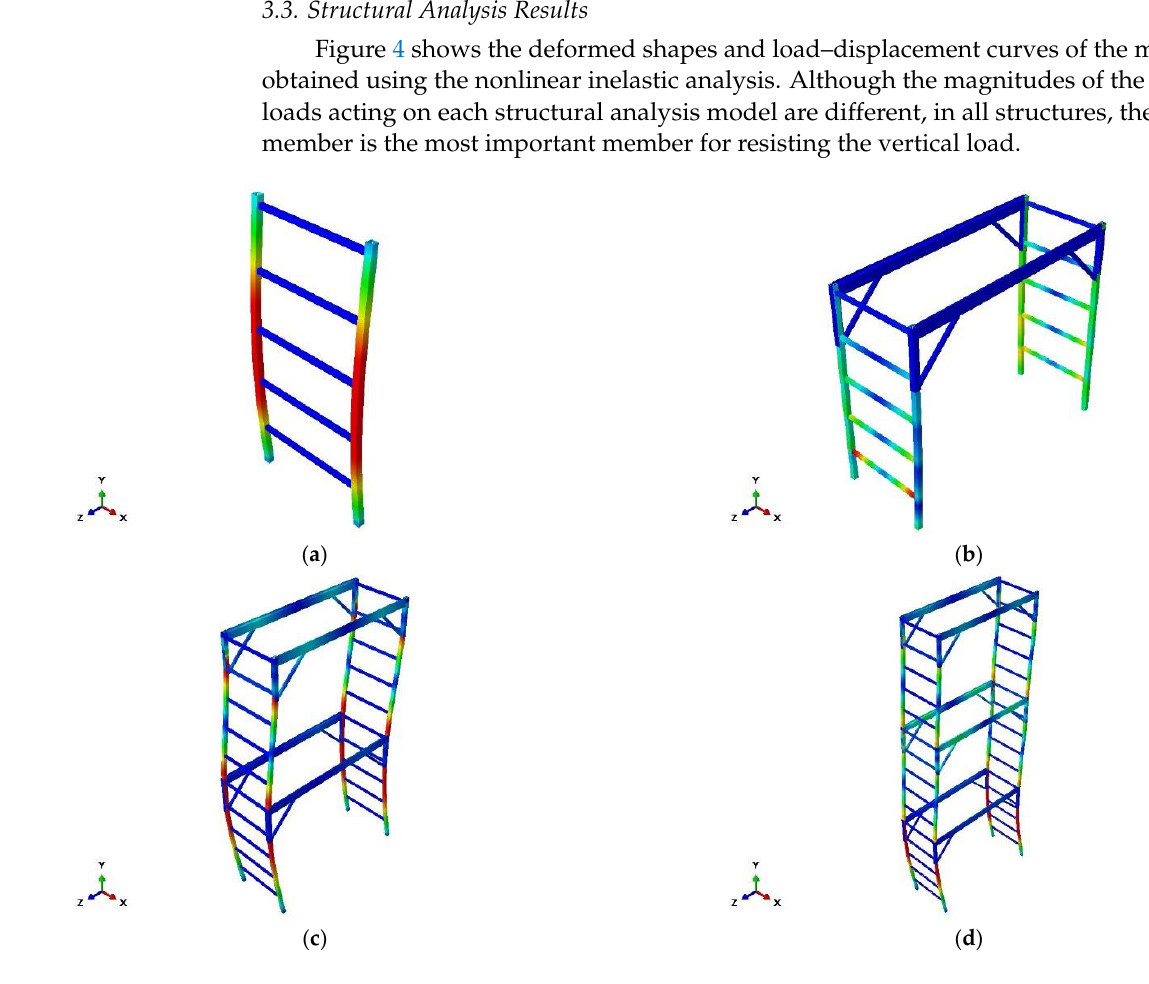
Figure 4. Deformation shapes of fabricated mobile scaffolds and mainframe according to structural analysis. ( a ) Mainframe. ( b ) Single-story. ( c ) Two-story. ( d ) Three-story.